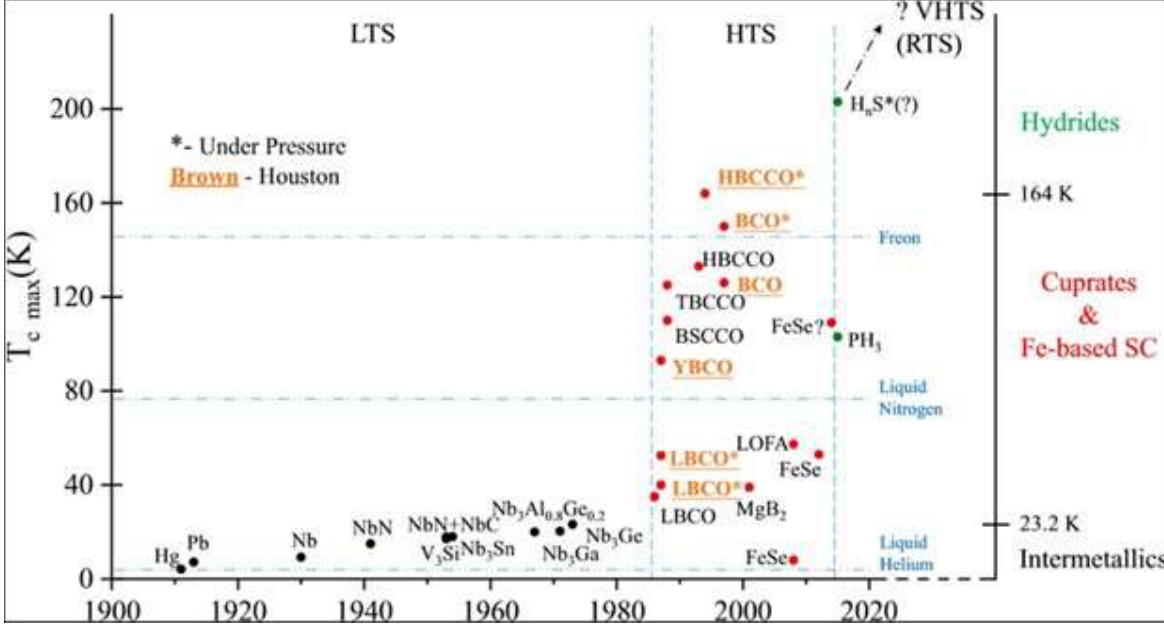
Figure 4: A graph of critical temperature vs. time